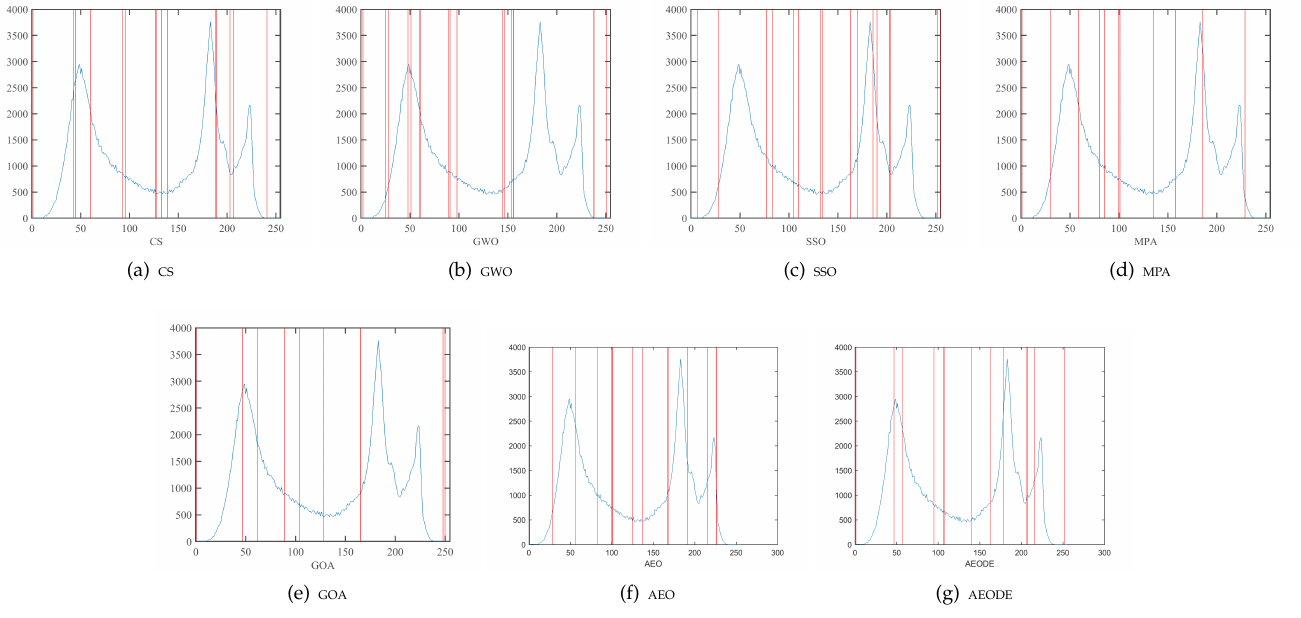
Figure 12. The threshold values at level 19 over the histogram of image